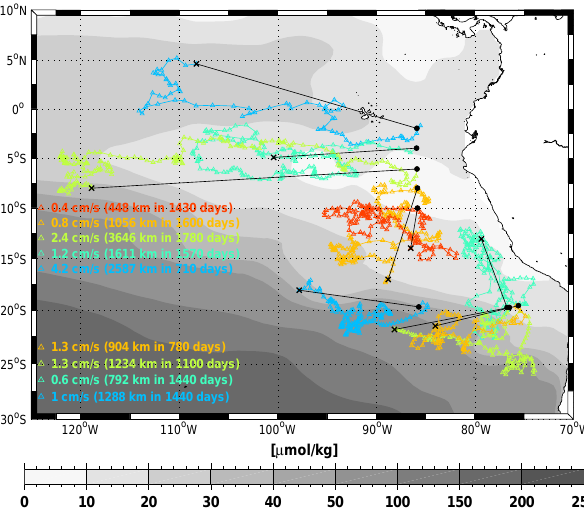
Figure 5. Floats drifting at 400dbar deployed in February 2009 along 85 ◦ 50 (cid:48) W and in April 2011 along 20 ◦ S (in color) with mean velocity information for the entire lifetime of the floats or until March 2015 for floats which are still active. The symbols show the surfacing location every 10 days, the black line marks the connec- tion between the deployment position and the last position used. Grey background field is the annual mean CARS 2009 (Ridgway et al., 2002) climatological oxygen distribution in µmolkg − 1 at 400m depth.